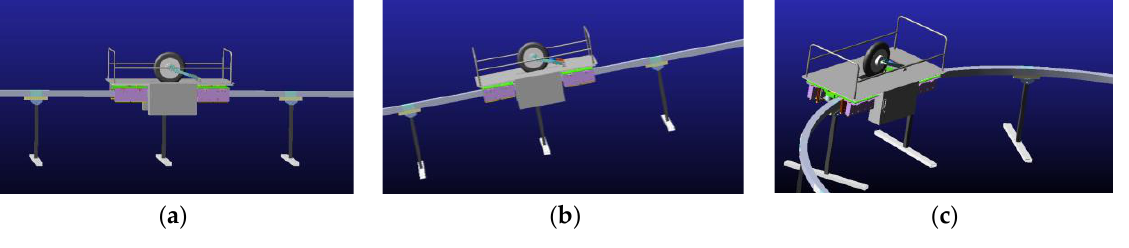
Figure 5. monorail car simulation experiment . ( a ) horizontal straight track ( b ) climbing straight Figure 5. Monorail car simulation experiment. ( a ) horizontal straight track ( b ) climbing straight track track ( c ) horizontal curved track. ( c ) horizontal curved